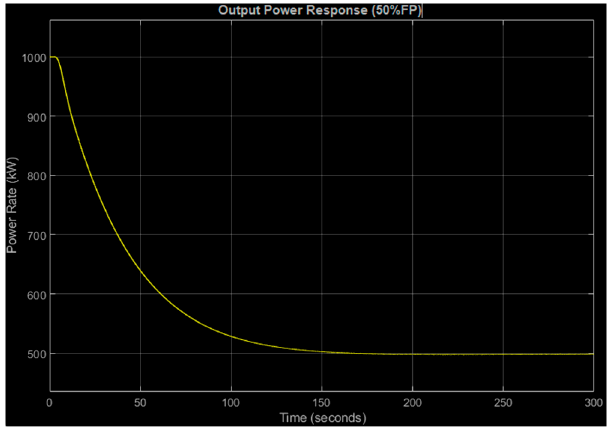
Figure 17. Output power response: input at 50% full power.